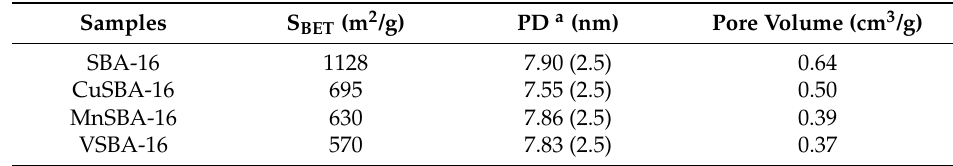
Figure 2. XRD temperature-programmed reduction of the Cu/SBA-16, V/SBA-16 and Mn/SBA-16 catalysts. Table 3. Textural properties of the studied SBA-16 samples.